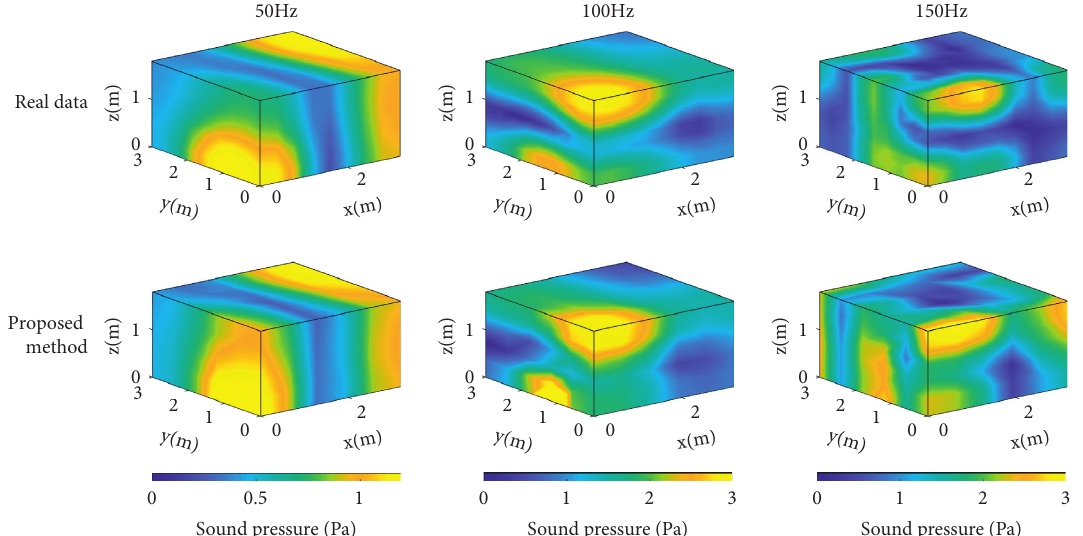
Figure 8: Sound pressure distributions of the real data and the proposed method under excitation of three monopoles at 50Hz, 100Hz, and